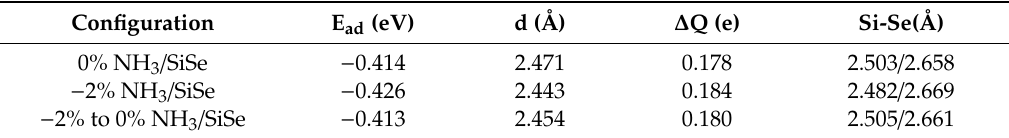
Table 2. The adsorption energy (E ad ), closest distance (d), Mulliken charge transfer ( ∆ Q), and the Si-Se bond of horizontal and vertical